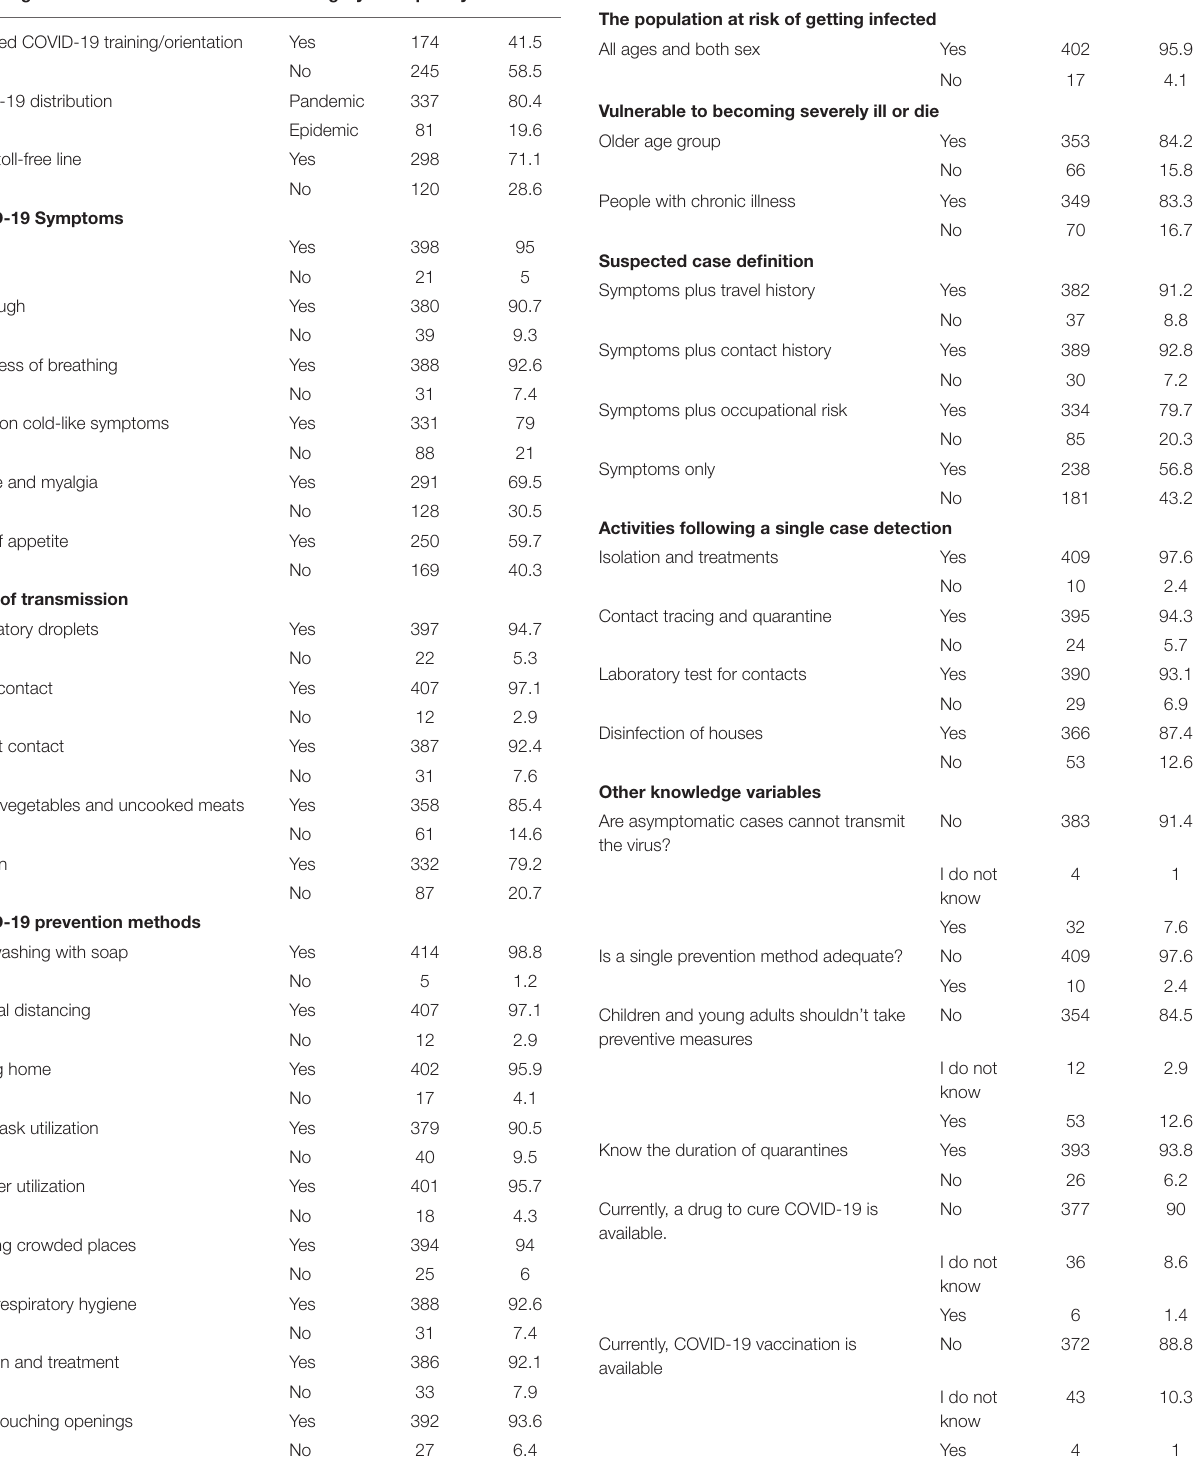
TABLE 2 | Health professionals’ knowledge regarding COVID-19 in Dessie city, northeast Ethiopia ( N =